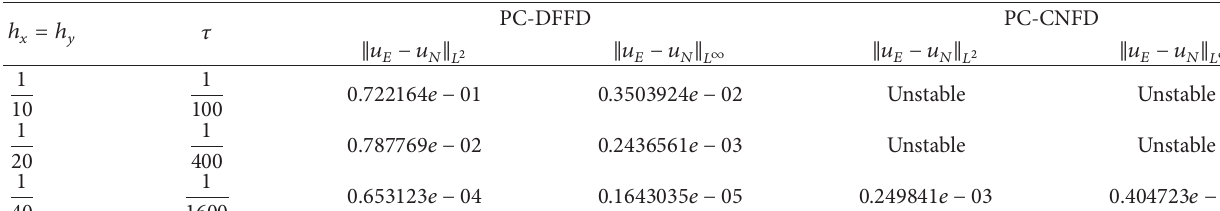
Table 1: Two different errors for ‖𝑢 𝐸 − 𝑢 𝑁 ‖ 𝐿 2 and ‖𝑢 𝐸 − 𝑢 𝑁 ‖ 𝐿 ∞ at 𝑇 = 7 .